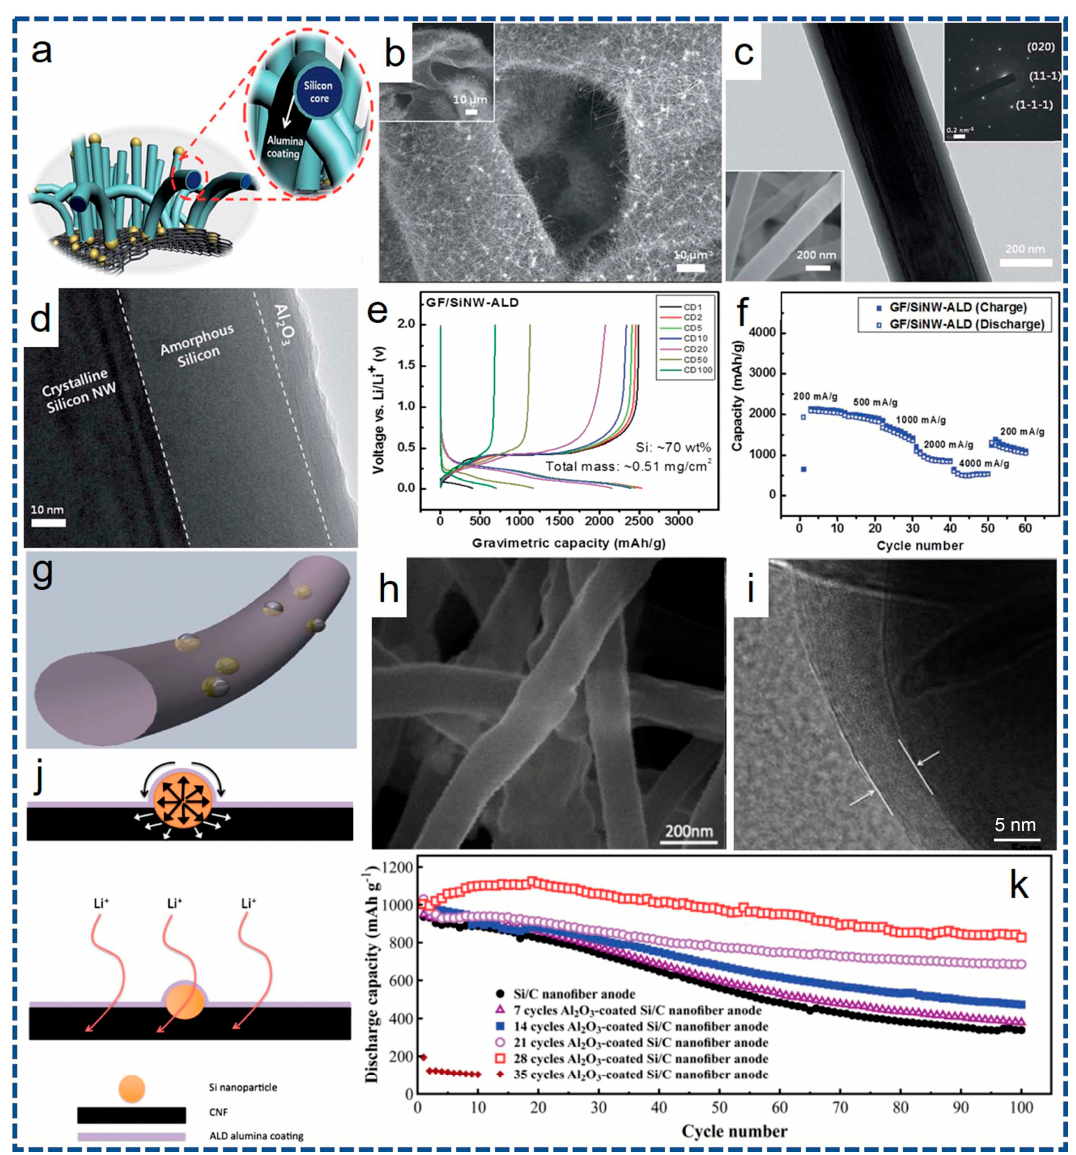
Figure 7. ( a ) Schematic illustration of ALD Al 2 O 3 -coated Si NWs grown on 3D porous graphene foam. ( b ) SEM images of Si NWs. ( c ) TEM and ( d ) High resolution transmission electron microscopy (HRTEM) images of a single Al 2 O 3 -coated Si NW. ( e ) Voltage profiles of for the 1st, 2nd, 5th, 10th, 20th and 50th cycles of Al 2 O 3 -coated Si NWs. ( f ) Rate capability of the Al 2 O 3 -coated Si NW composite with various currents as indicated. ( g ) Schematic of Al 2 O 3 -coated Si/C composite NFs. ( h ) SEM and ( i ) TEM image of Al 2 O 3 -coated Si/C composite NFs with 28 ALD cycle numbers. ( j ) Schematic of physical/mechanical (upper) and chemical protective effect (down). ( k ) Cycling performance of Si/C composite NFs and Al 2 O 3 -coated Si/C composite NFs. ( a – f ) reprinted with permission from Ref. [129]